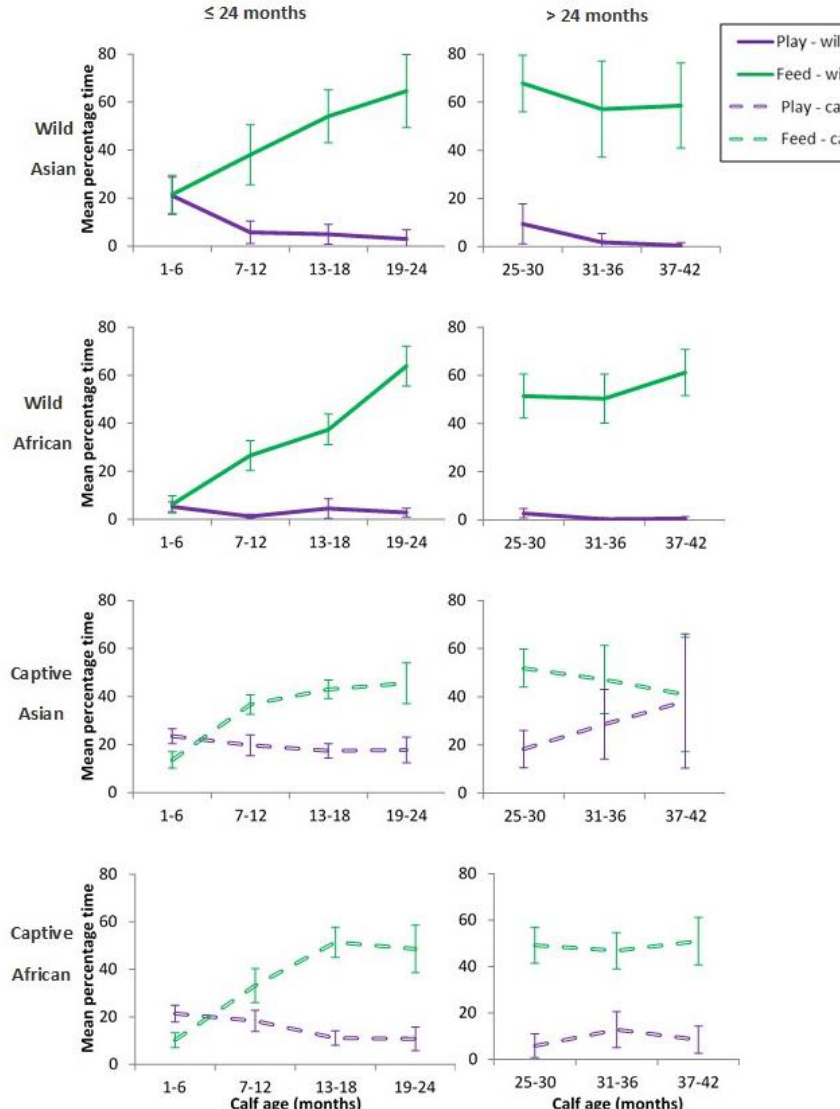
Figure 3. The relationship between the mean percentage of observation time ( ± 95%CI) in total play and independent feeding by context from birth to 3.5 years. Charts separated within context, for ≤ 24 months and for > 24 months.